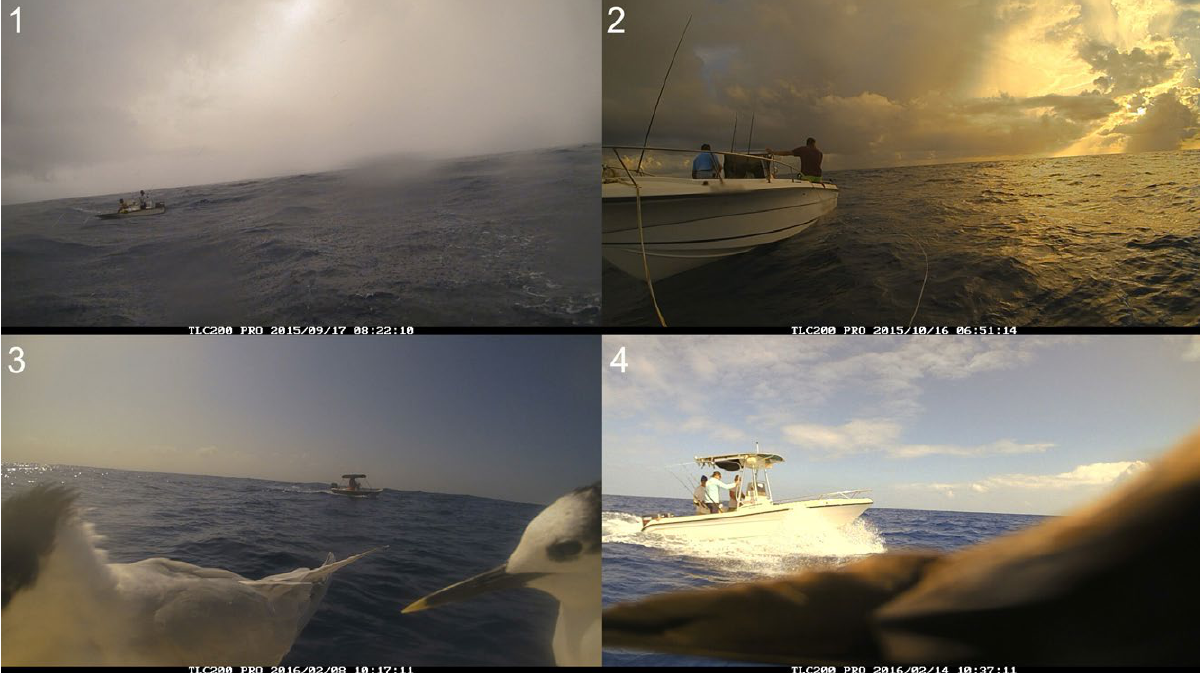
Fig. S5. – Clockwise from upper left: (1) Vessel #50 present in squall; this vessel was named “g_very_sm_lowris_centercons”; (2) Vessel #57 shown tying up to buoy F; (3) Example of image with vessel and birds blocking a portion of the field of view; (4) Example of image with vessel with a bird blocking a greater portion of the field of